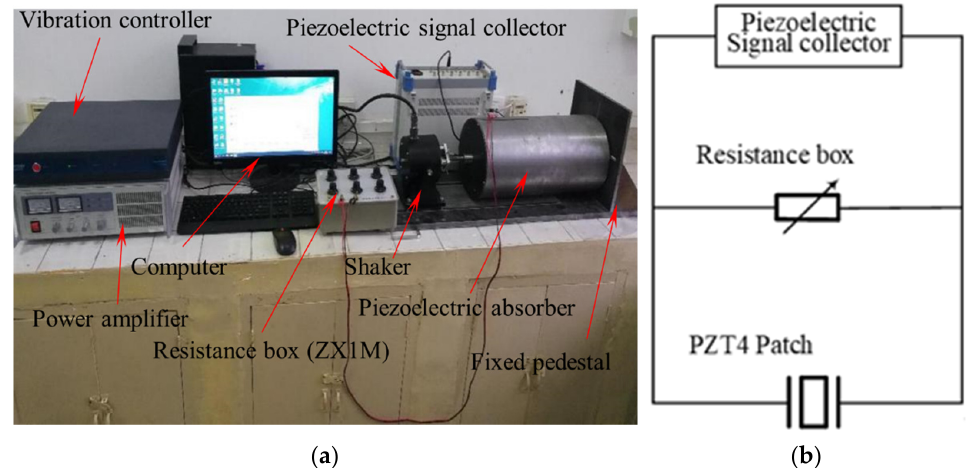
Figure 4. The experiment setup and electric circuit of the piezoelectric damper. ( a ) experiment setup; ( b ) electric circuit.